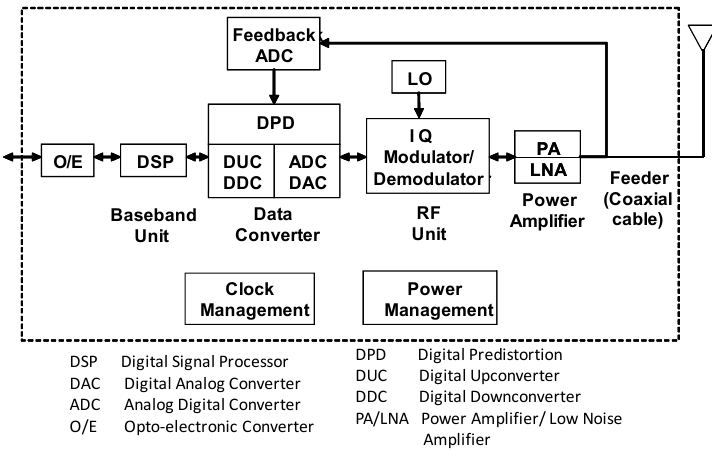
Figure 6. Conventional base station architecture incorporating BBoF transport